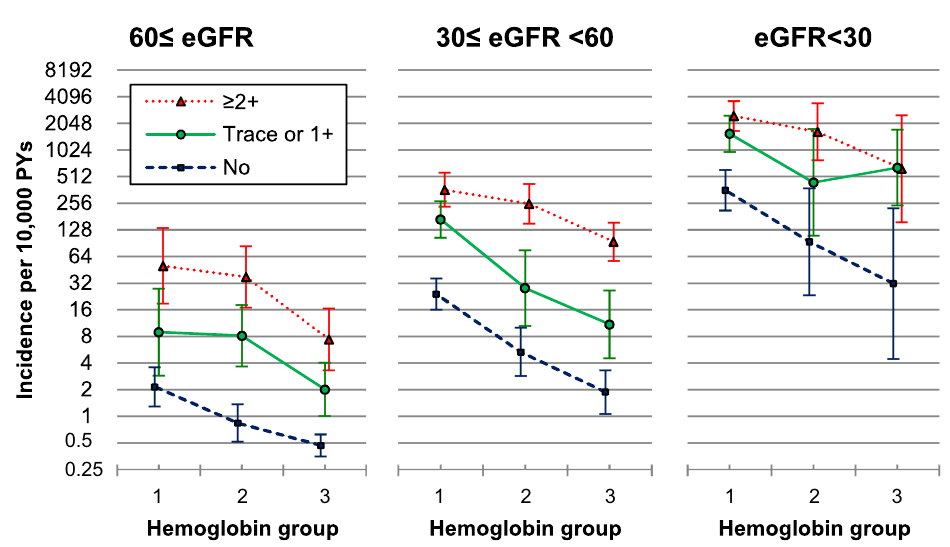
Fig 2. Age-adjusted � incidence of ESRD in 27 combined hemoglobin, albuminuria, and eGFR groups. ESRD, end-stage renal disease; eGFR, estimated glomerular filtration rate using the Chronic Kidney Disease Epidemiology Collaboration (CKD-EPI) creatinine equation. Hemoglobin groups 1, 2, and 3 correspond to < 11, 11–11.9 and � 12 g/dL, respectively, in women, and < 13, 13–13.9 and � 14 g/dL, respectively, in men. � Poisson regression was used.